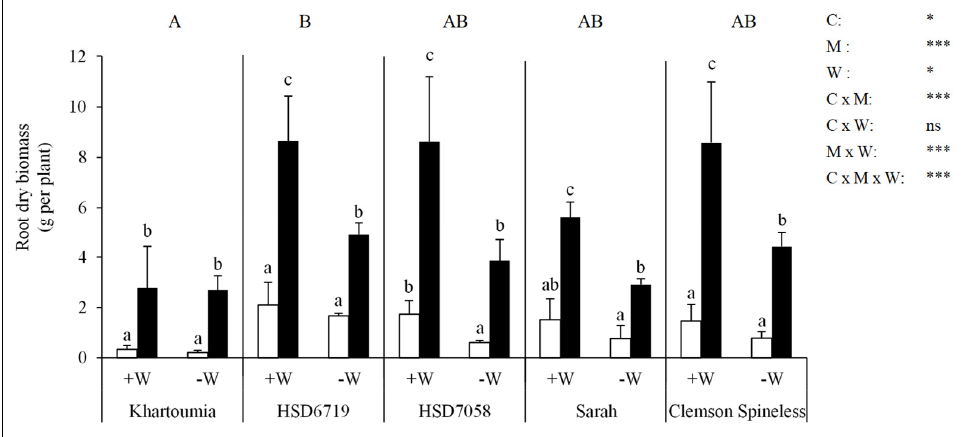
Figure 5. Root dry biomass in five okra cultivars. For definitions of treatments and statistics, refer to the text for Figure 4.